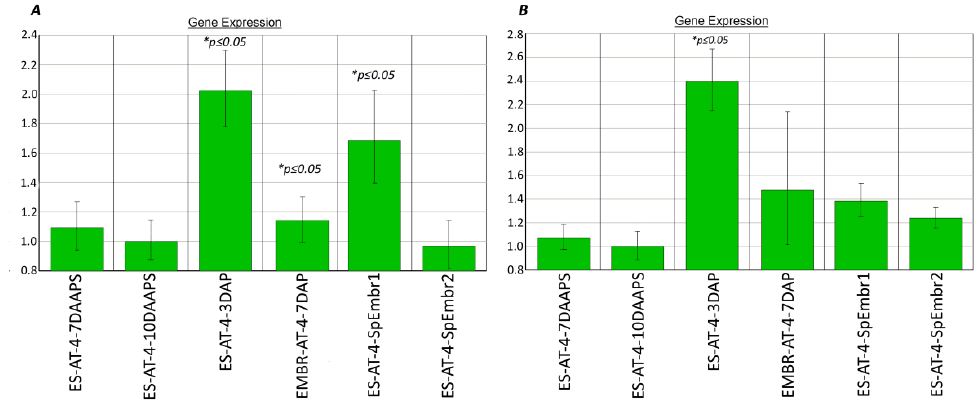
Figure 4. Histone deacetylase ( hdt104 ) ( A ) and histone linker ( hon101 ) ( B ) expression in parthenogenic proembryos* (10 DAAPS) and ESs (7–10 DAAPS). Controls: ESs at 10 DAAPS for ( A ) and ( B ). *ES-AT-4, 7 and 10 DAAPS: in one biological experiment, each sample consisted of 12 unpollinated ESs. Data are from four independent biological experiments.